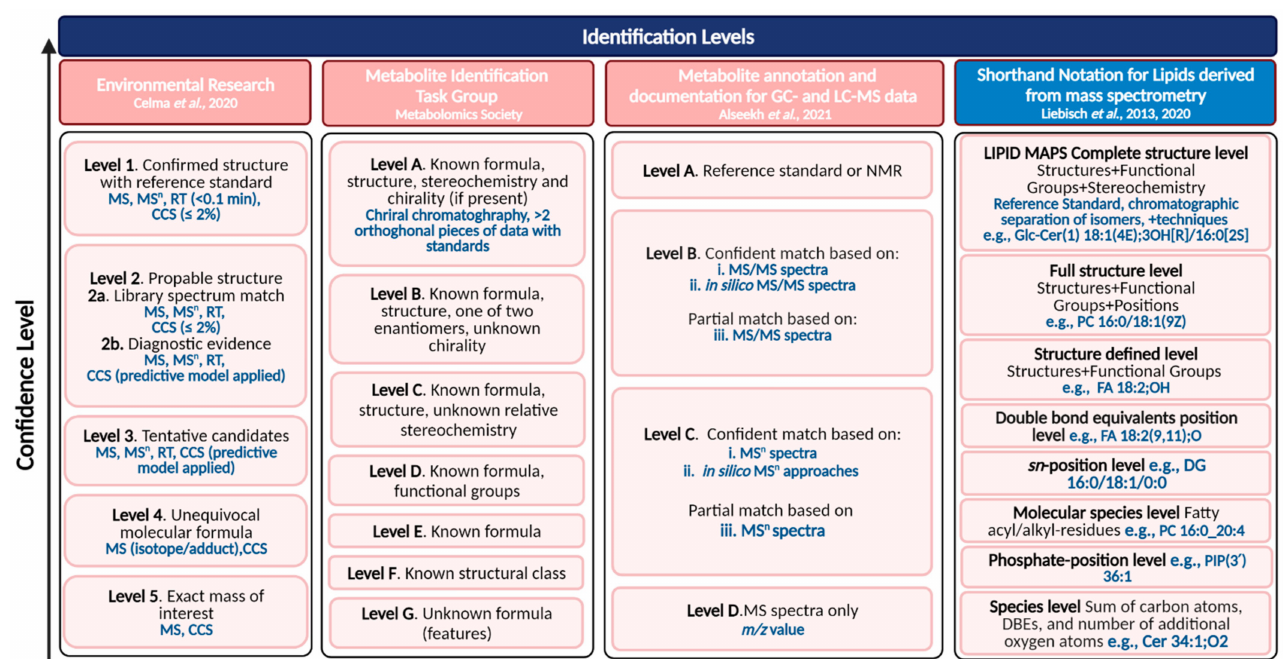
Figure 2. Overview of confidence levels in compound annotation using different scales. The figure was adapted from [125–128] and more detailed information about the mentioned confidence levels can be found in